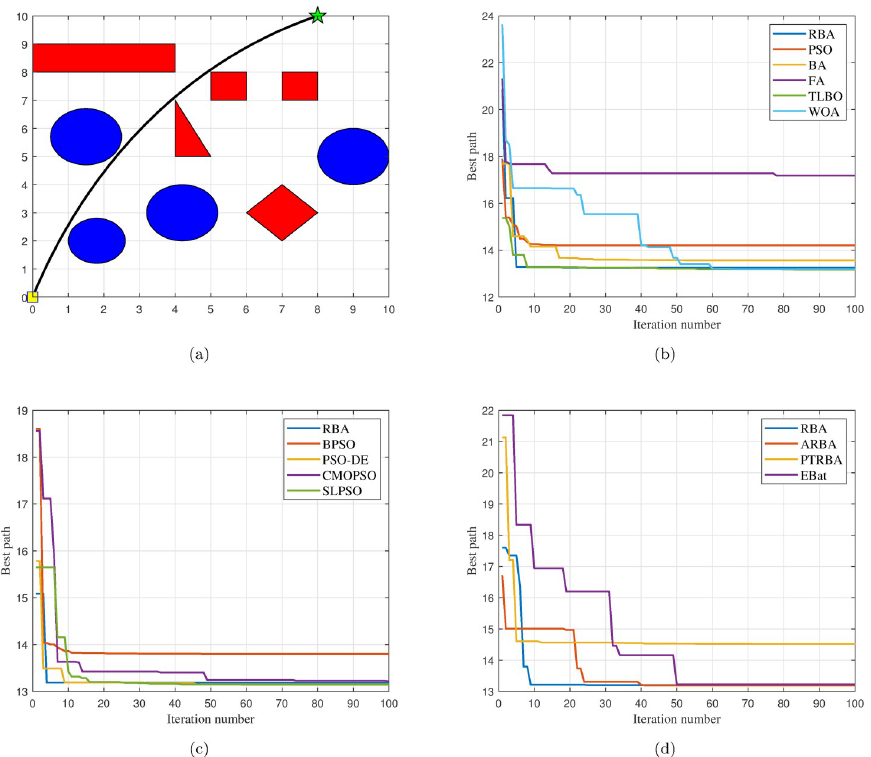
Fig 5. The path planning results in the test case 1 and the number of iterations of all algorithms when the path is implemented. (a) Optimal path. (b) Iteration curves of RBA and classical algorithms. (c) Iteration curves of RBA and PSO variants. (d) Iteration curves of RBA and BA